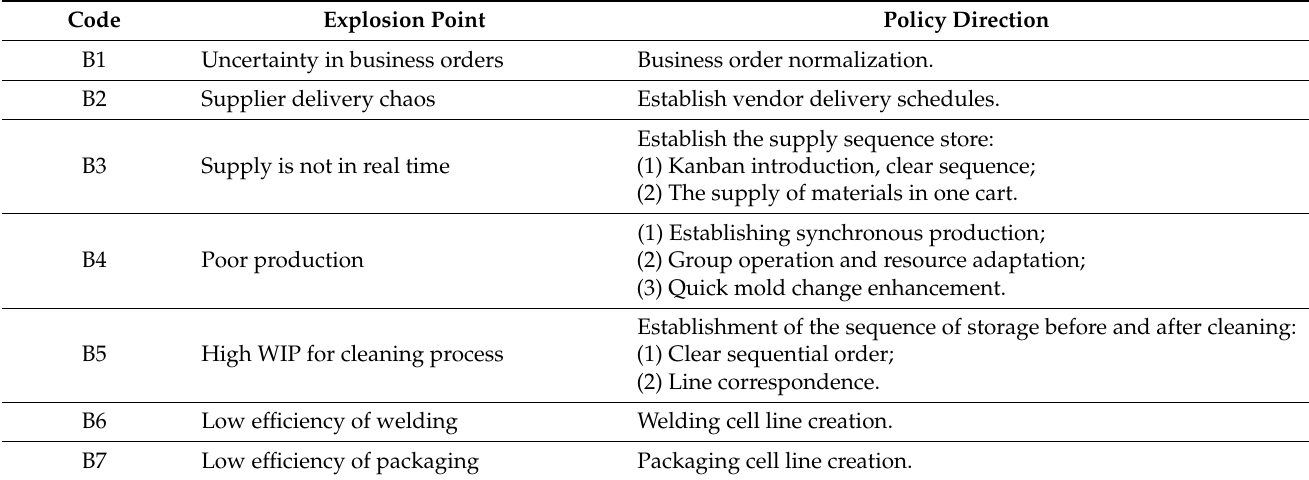
Table 2. VSM explosion improvement